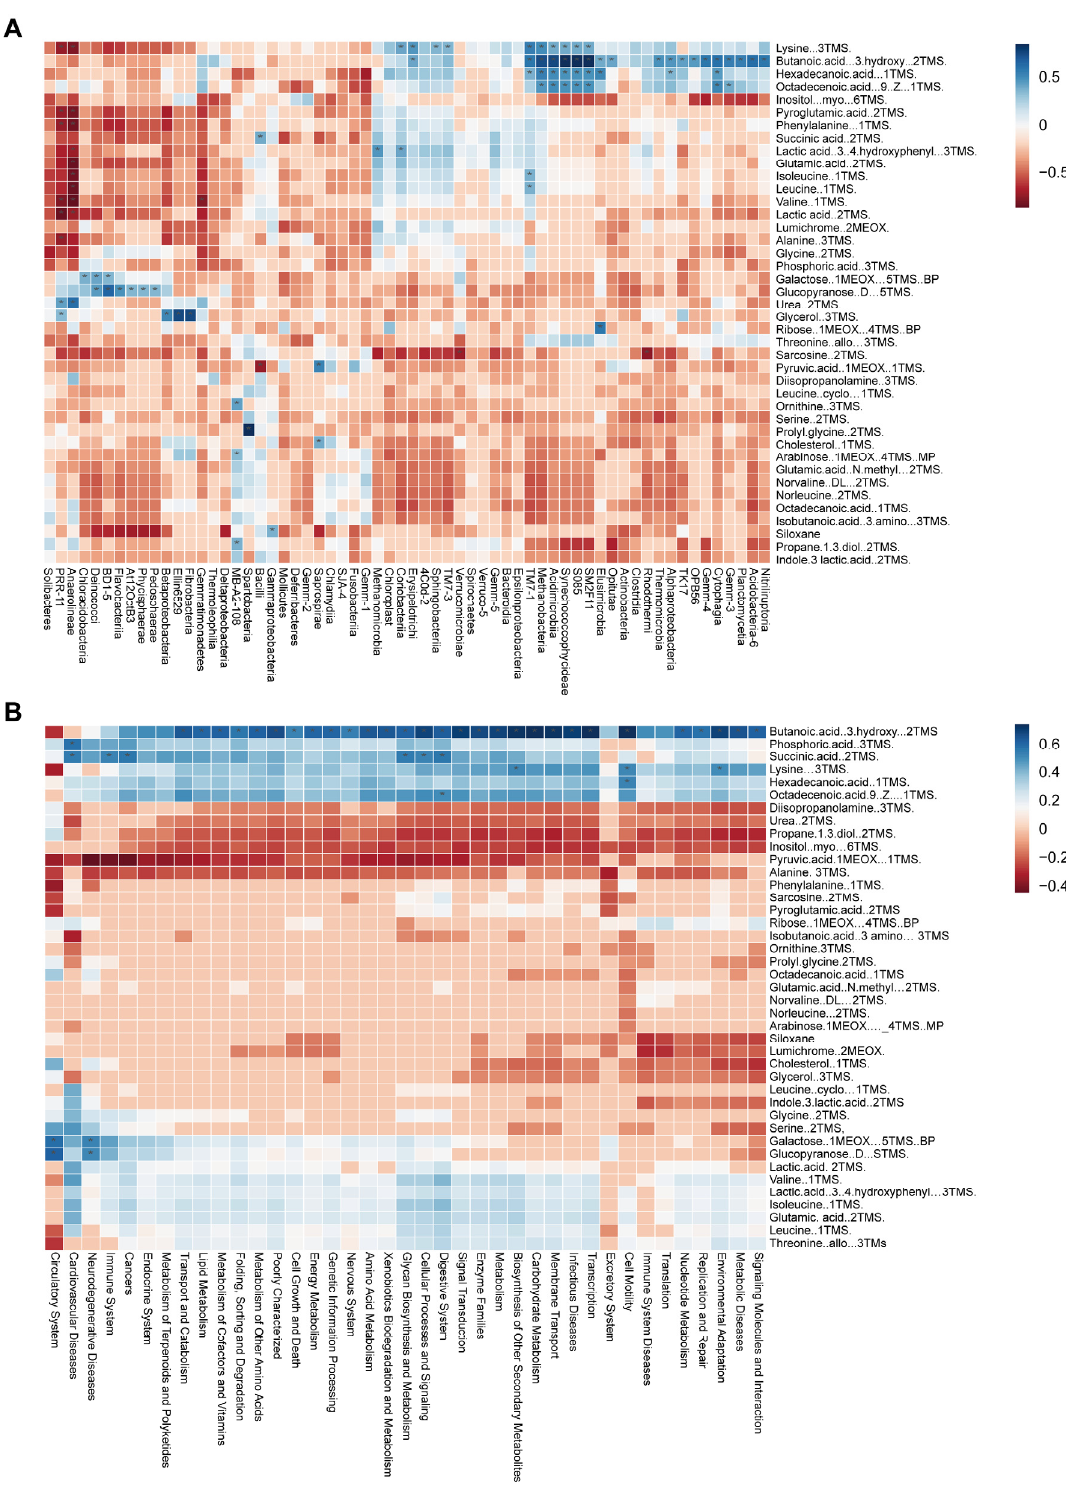
Figure 4. Correlation of nasal microbiota and serum metabolites in cattle. ( A ) Heat map summarizing the correlation between nasal flora and serum metabolites. ( B ) Heat map summarizing the correlation between gene function and metabolites. The red and blue gradient color bar visually shows the correlation between microbes and metabolites. A darker color is associated with a stronger correlation. Red indicates a positive correlation and blue indicates a negative